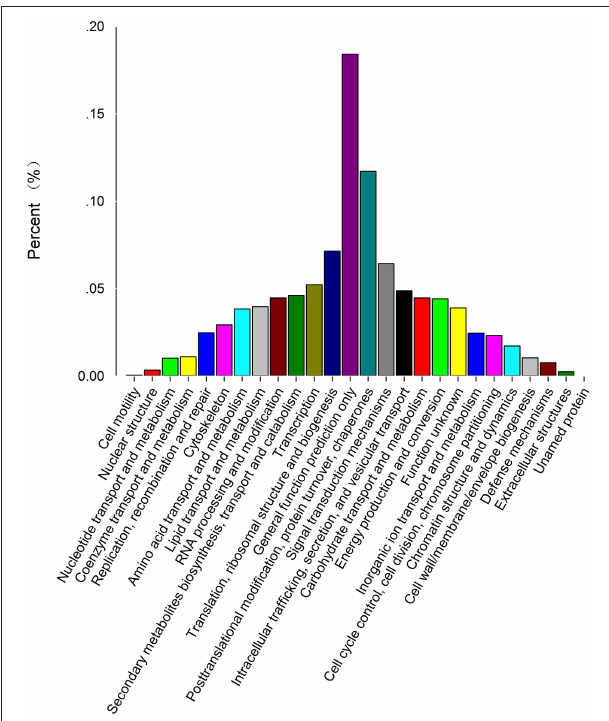
FIGURE 3 | KOG classification of unigenes. Eight thousand six hundred forty-three unigenes with Nr hits were grouped into 26 KOG terms. The Y-axis represents the percentage of all unigenes.